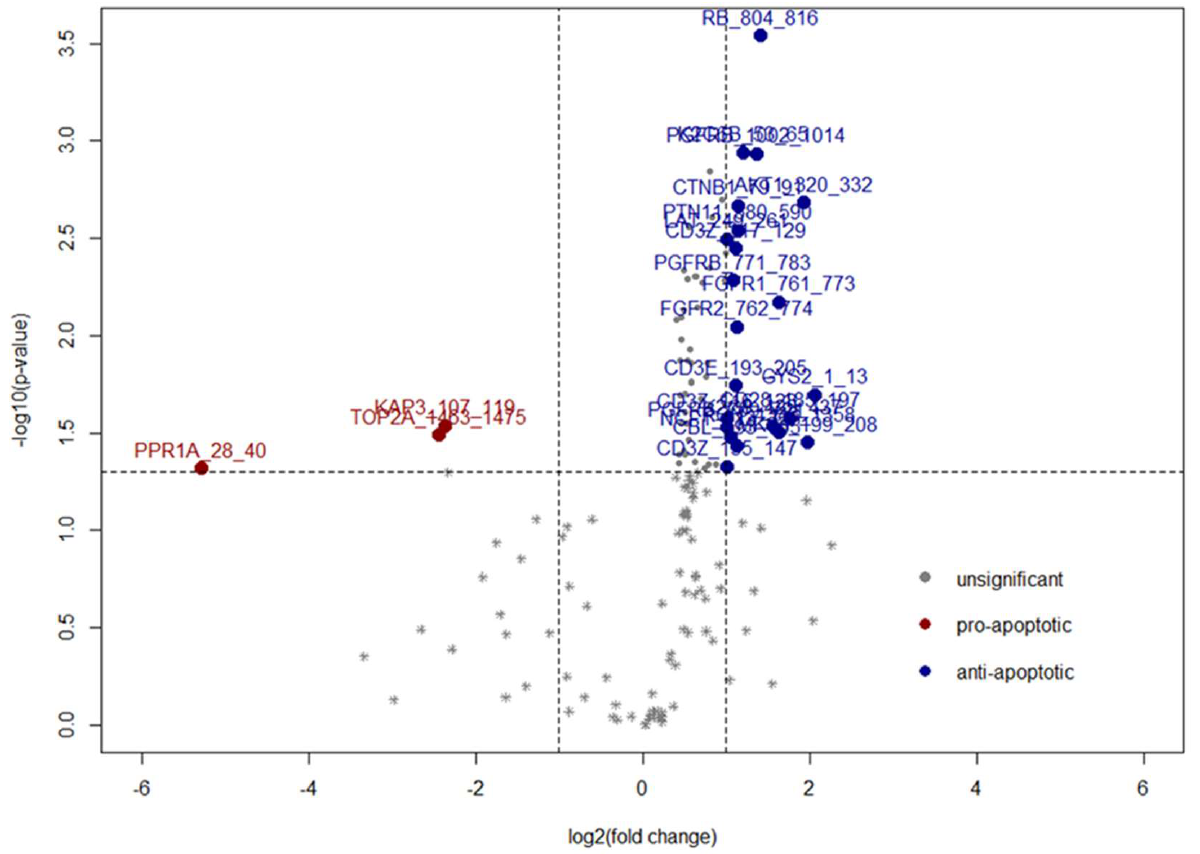
Figure 2. Volcano plot of phosphotsites associated with changes in apoptosis of FB CM-treated MPM cell lines.